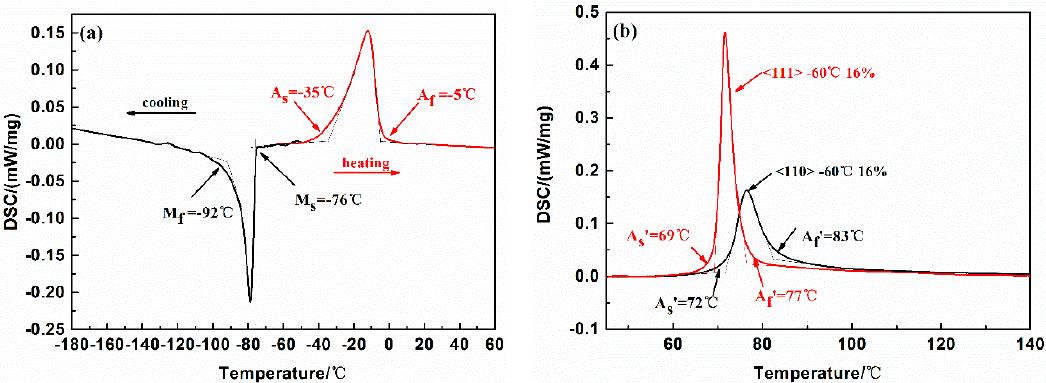
Figure 8. Differential scanning calorimetry (DSC) curves ( a ) before and ( b ) after tension to 16% at − 60 °C along the <111> and <110> direction.